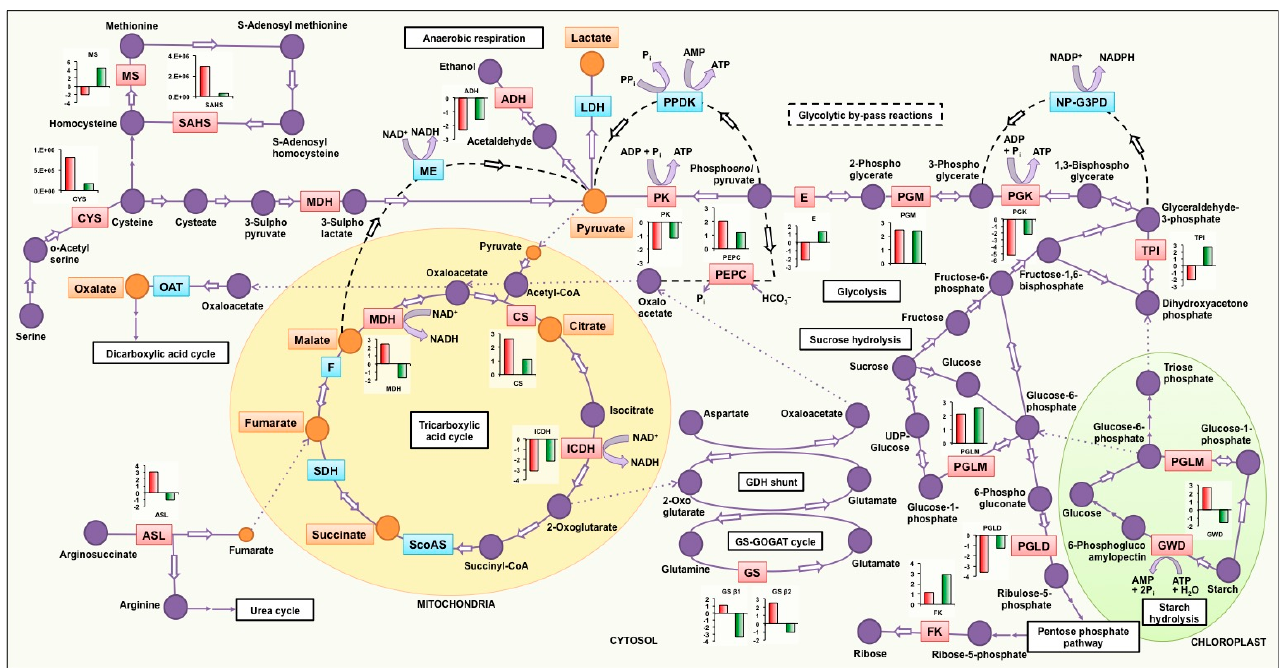
Figure 7. Model depicting involvement of several enzymes in carboxylic acid synthesis and glycolytic by-pass pathways functioning under low P stress in soybean roots. Carboxylic acids indicated in orange boxes were detected in the root exudates of soybean. Enzymes denoted in red boxes are differentially abundant under low P stress, relative fold change at low P compared to sufficient P in contrasting genotypes are denoted in red (EC-232019) and green (EC-113396) bars. Enzymes denoted in blue boxes might have a possible role in increasing carboxylic acid synthesis or glycolytic by-pass reactions under P stress. ADH: Alcohol dehydrogenase, ASL: Argininosuccinate lyase, CS: Citrate synthase, CYS: Cysteine synthase, E: Enolase, F: Fumarase, FK: Fructokinase, GDH: Glutamate dehydrogenase, GOGAT: Glutamate oxoglutarate amino transferase, GS: Glutamine synthetase, GWD: α -glucan water dikinase, ICDH: Isocitrate dehydrogenase, LDH: Lactate dehydrogenase, MDH: Malate dehydrogenase, ME: Malic enzyme, MS: Methionine synthase, NP-G3PD: Non-phosphorylating NADP dependent glyceraldehyde-3-phosphate dehydrogenase, OAT: Oxaloacetase, PEPC: Phospho enol pyruvate carboxylase, PGK: Phosphoglycerate kinase, PGLD: Phosphogluconate dehydrogenase, PGLM: Phosphoglucomutase, PGM: Phosphoglycerate mutase, PK: Pyruvate kinase, PPDK: Pyruvate phosphate dikinase, SAHS: S-adenosyl homocysteine synthase, ScoAS: Succinyl coenzyme A synthetase, SDH: Succinate dehydrogenase, TPI: Triosephosphate isomerase. PEPC, CS and PK data derived from enzyme activity (data published in Vengavasi et al.